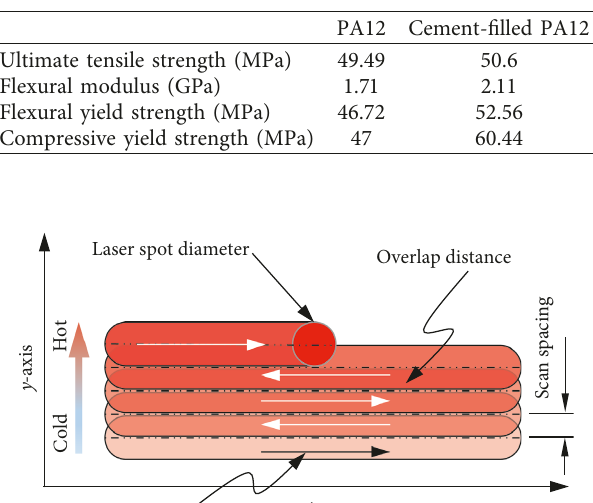
Table 5: Comparison between the mechanical properties of PA12 and cement-filled PA12 (10% white cement, LP